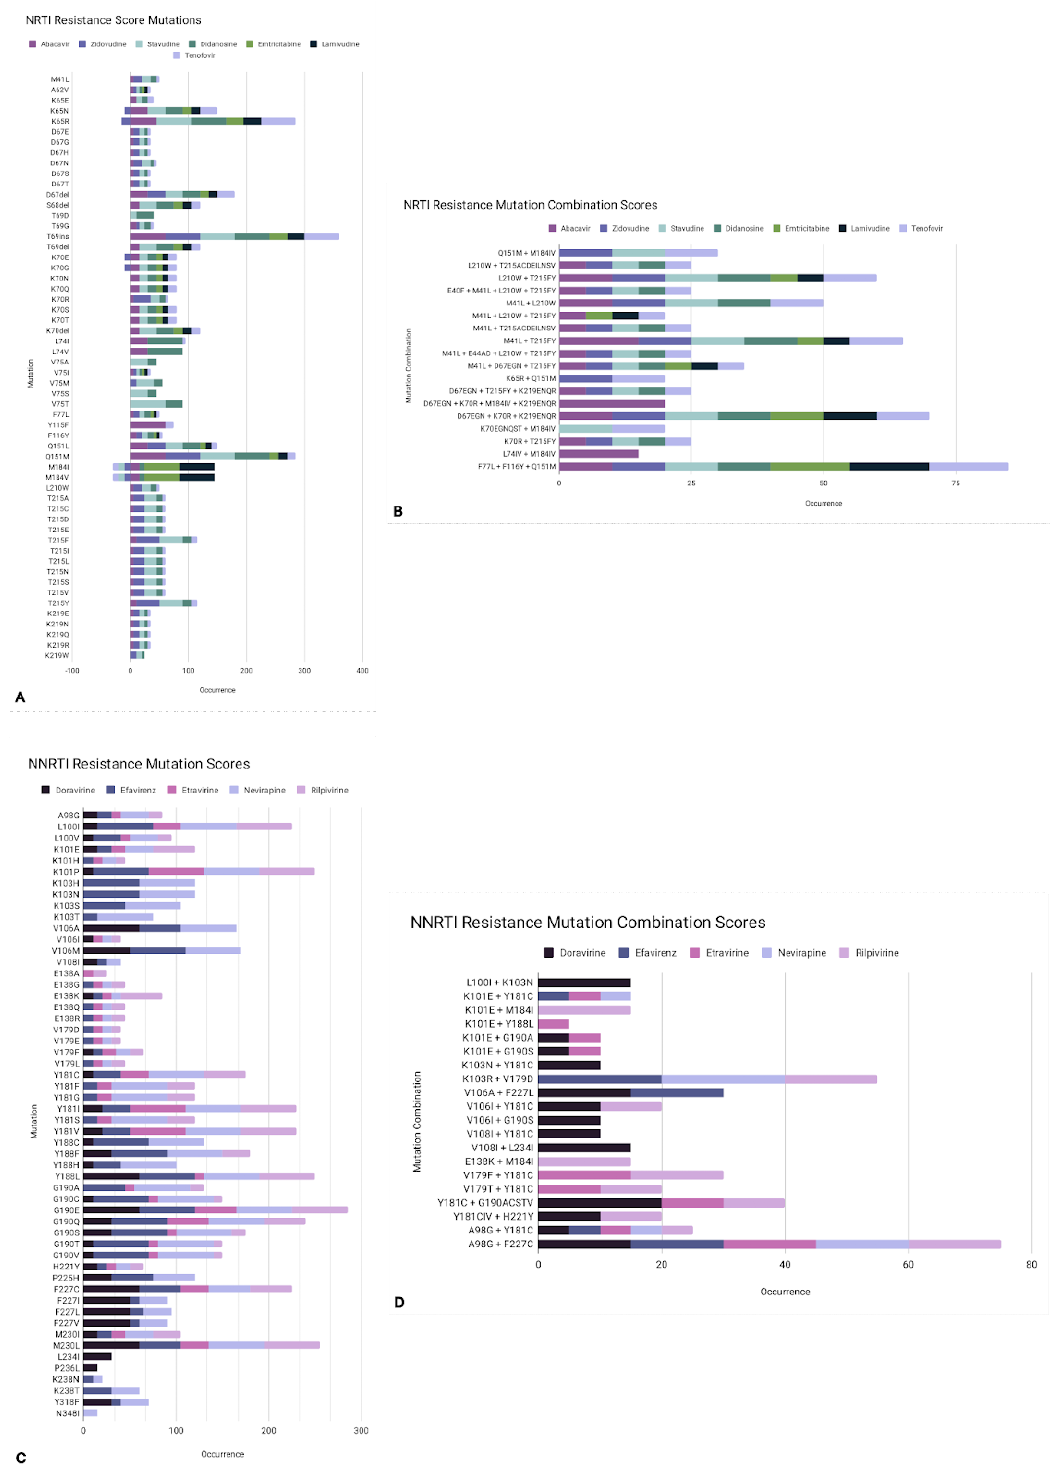
Figure 8. HIV RT-inhibitor resistance mutation scores. These resistance scores, when shown in aggregate, can reflect hotspots in the HIV genome which confers resistance to several drugs. Colors represent different drugs, with occurrence rates combined additively. Any negative value represents that HIV had increased susceptibility (instead of resistance) to that drug. NRTI ( A ) and NNRTI ( C ) mutations are shown. Combinations of mutations are also shown ( B , D ) that usually include primary mutations that allow drug escape plus compensatory mutations that reduce fitness costs.